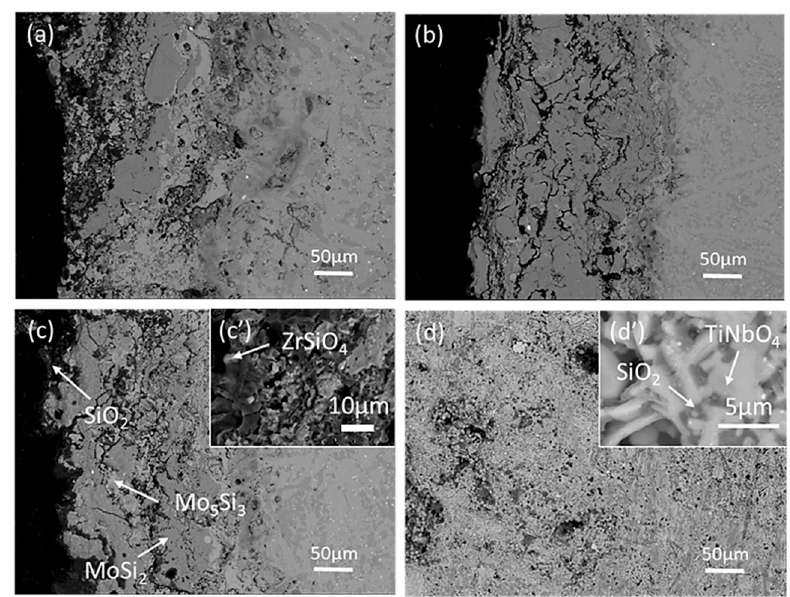
Figure 8. Cross-section morphology of MoSi 2 -ZrB 2 coatings after oxidation in air at 1250 °C for 60 h: ( a ) mz40, ( b ) mz43, ( c ) mz45 and ( d ) the failure edge of the mz40 Table 3. The EDS results of constituent phase of the oxidized mz45 sample (at.%). Element Mo